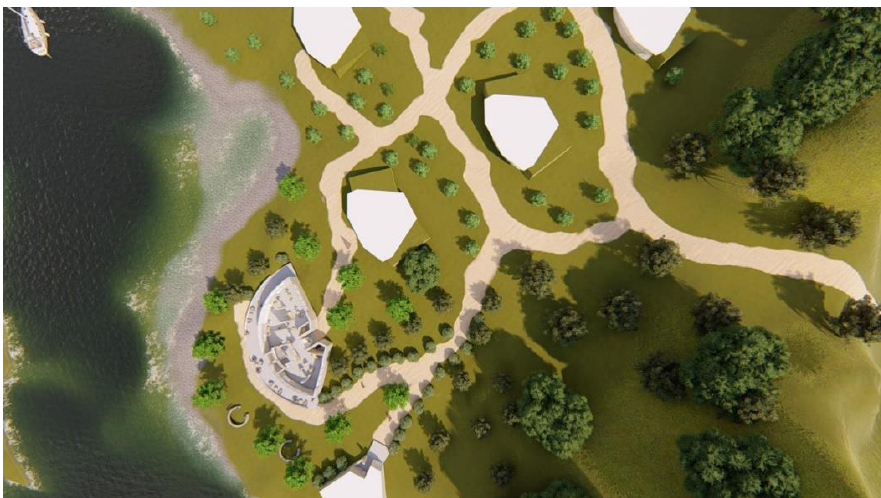
Figure 45. Visitors Centre and part of the tourist resort Lepenski Vir, which clearly show the traditional urbanism used ages ago. Lepenski Vir, Serbia (2019) by ArhiArhi (Predrag, Vladimir and Grigor Milošević)